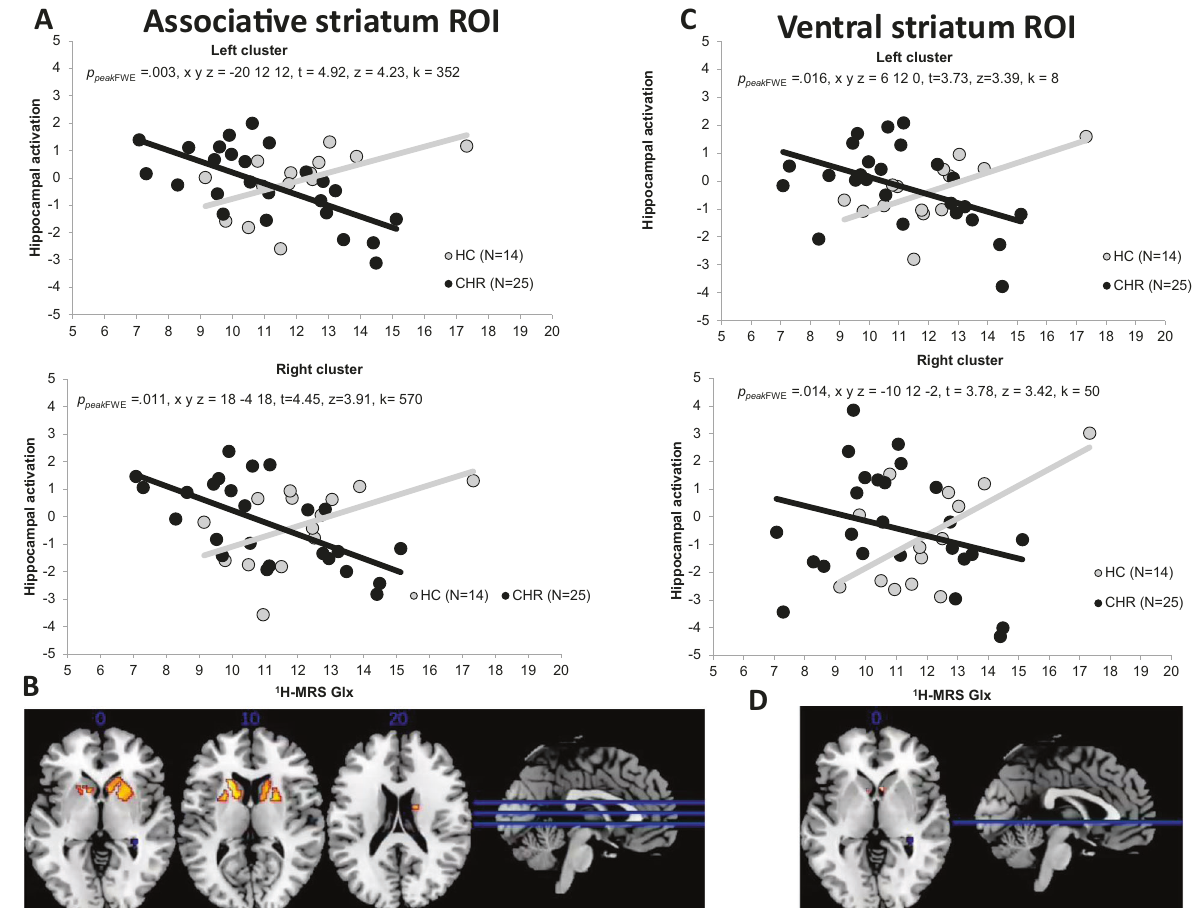
Fig. 3 Psychophysiological Interaction. ) Scatterplots showing PPI interactions between Group (CHR vs. HC) in the bilateral associative striatum and B ) SPM brain map (axial section) showing bilateral functional connectivity in bilateral associative striatum for the Group (CHR vs HC) x hippocampal Glx during novel > neutral oddball trials (p FEW < 0.025). C Scatterplots showing PPI interactions between Group (CHR vs. HC) in the bilateral ventral striatum and D ) SPM brain map (axial section) showing bilateral functional connectivity in bilateral ventral striatum for the Group (CHR vs. HC) x hippocampal Glx during novel > neutral oddball trails (p FWE < hippocampal Glx concentrations and hippocampal – striatal con-